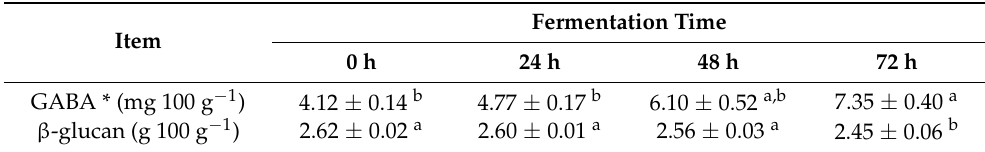
Table 3. Gamma-aminobutyric acid and β -glucan contents in fermented oat extract during fermenta- tion up to 72 h (mean ± SE), n =